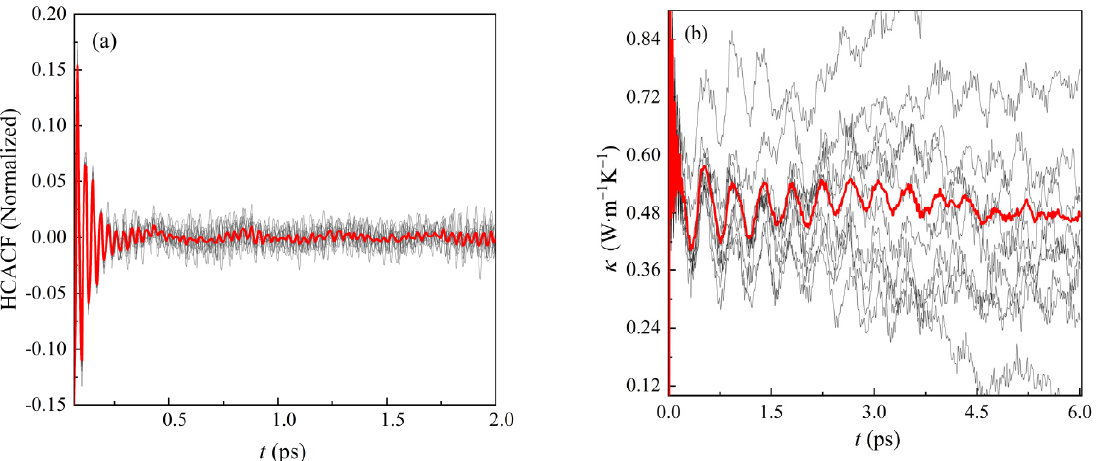
Figure 6. Thermal conductivity of CsPbBr 3 at 300 K calculated by the BV model. ( a ) Heat current autocorrelation function; ( b ) thermal conductivity κ .